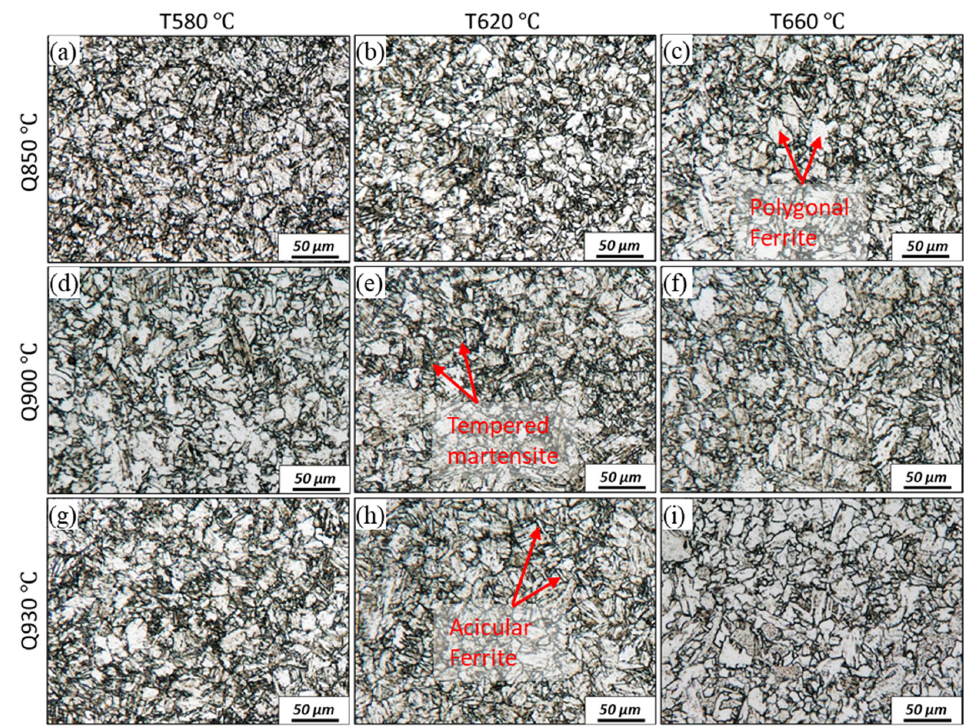
Figure 4. Microstructure of the specimens with different quenching and tempering processes: ( a ) Q850 °C + T580 °C, ( b ) Q850 °C + T620 °C, ( c ) Q850 °C + T660 °C, ( d ) Q900 °C + T580 °C, ( e ) Q900